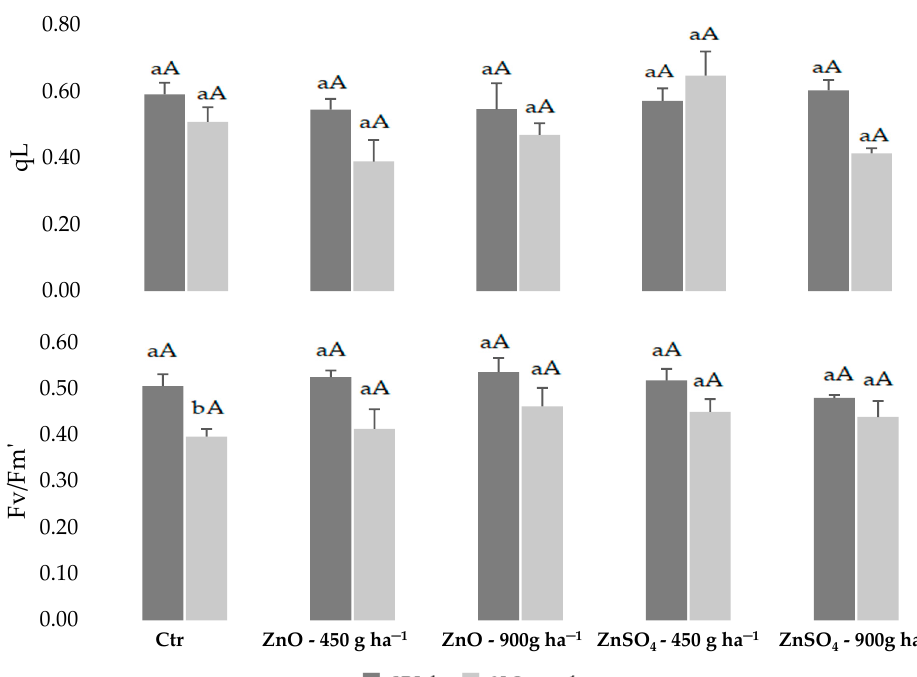
Figure 1. Mean values ± SE of chlorophyll a fluorescence, maximal photochemical efficiency of PSII (Fv/Fm), estimate of the quantum yield of photosynthetic noncyclic electron transport (Y( II )), estimate of the quantum yield of regulated energy dissipation (Y( NPQ )), and nonregulated energy (heat and fluorescence) dissipation (Y( NO )) of PSII, coefficient of non-photochemical (qN) and photochemical (qL) fluorescence quenching, and actual PSII efficiency of energy conversion under light (Fv’/Fm’) in leaves of Vitis vinifera L. variety Fernão Pires, submitted to Zn biofortification, on 27 July 2018 and 13 September 2018 (after the 3rd foliar spray). For each parameter, the mean values ± SE (n = 6) followed by different letters express significant differences among analytical dates for each treatment (a, b), or among treatments for the same analytical date (A, B, (statistical analysis using the single-factor ANOVA test, p ≤ 0.05).